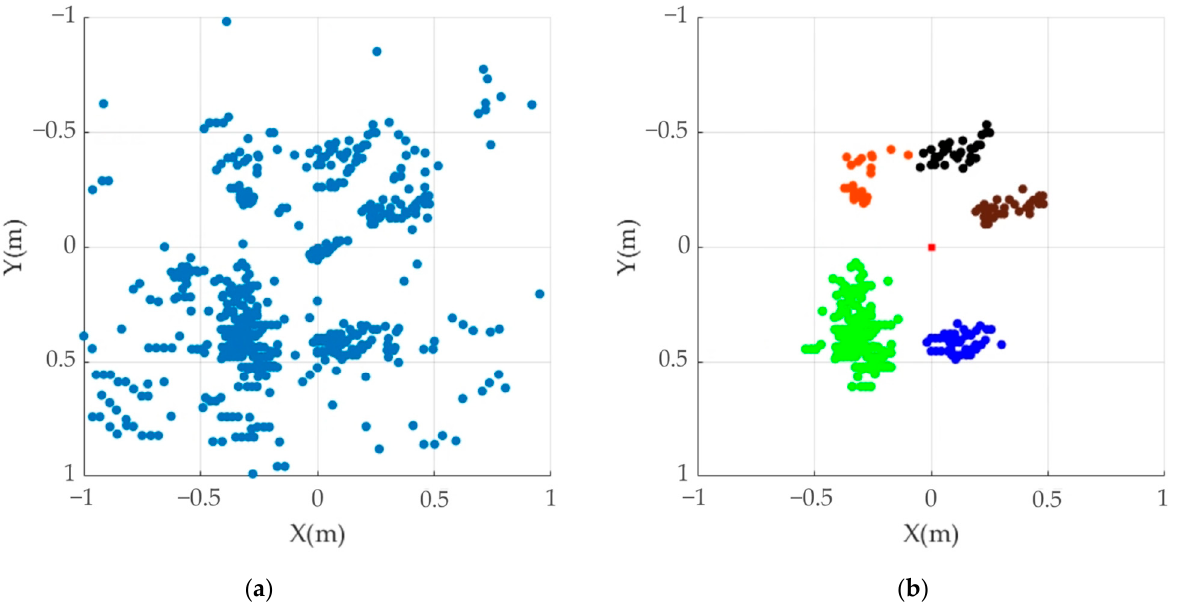
Figure 13. This image depicts the top view of a point cloud in a static use case involving three people leaning right in the back row. The original point cloud image is on the left ( a ), whereas the right figure ( b ) shows the result of the clustering and post-processing steps. Different colors are used to represent different categories of point clouds, with the positive Y-axis pointing towards the front.